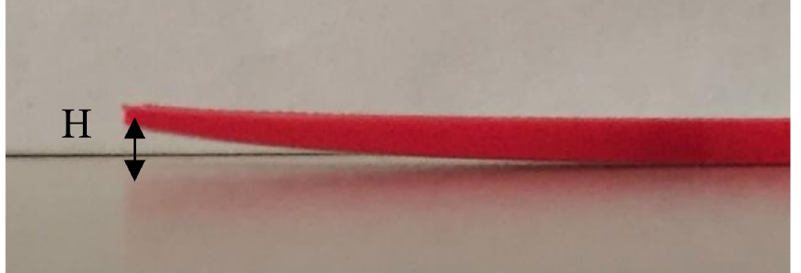
Figure 6. The warped edge of a sample.